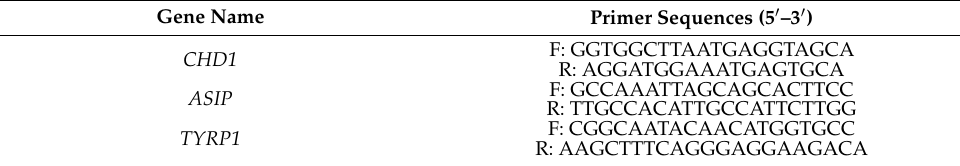
Table 2. Micro-trace whole blood PCR with real-time PCR primer